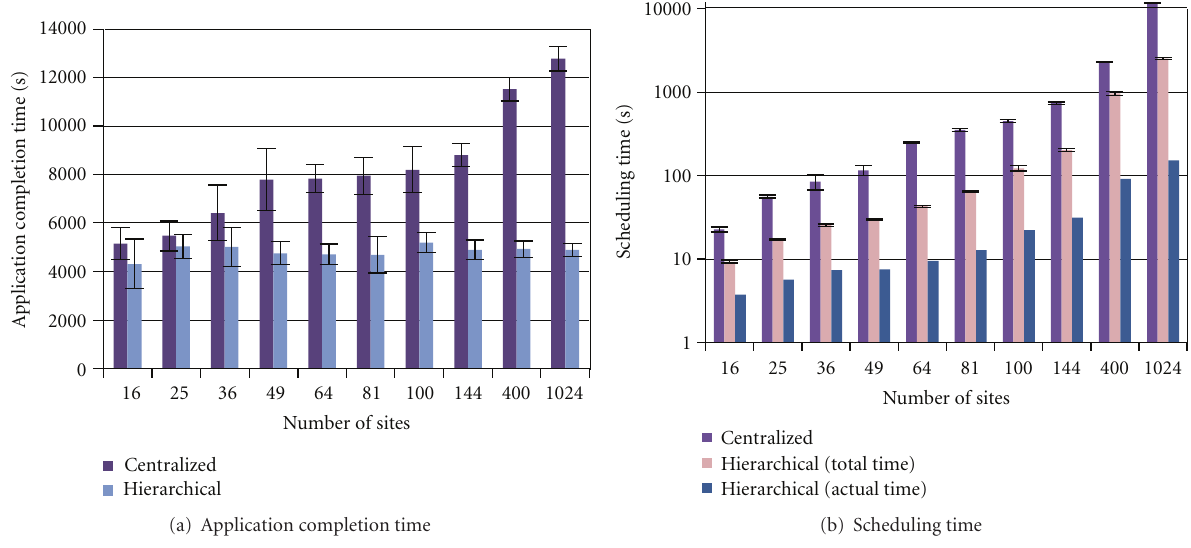
Figure 2: Hierarchical versus centralized for di ff erent network